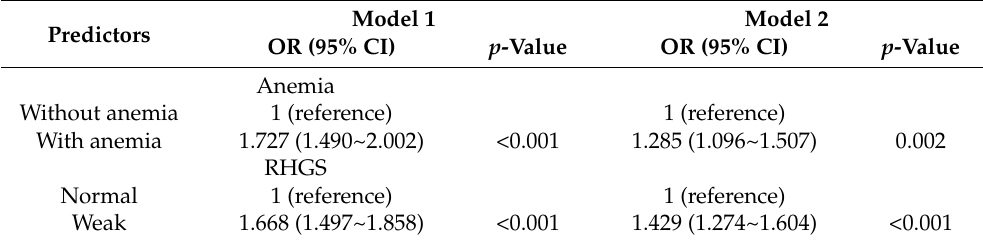
Table 2. Odds ratios (ORs) and 95% confidence intervals (CIs) of a lower HRQoL by anemia and handgrip strength.